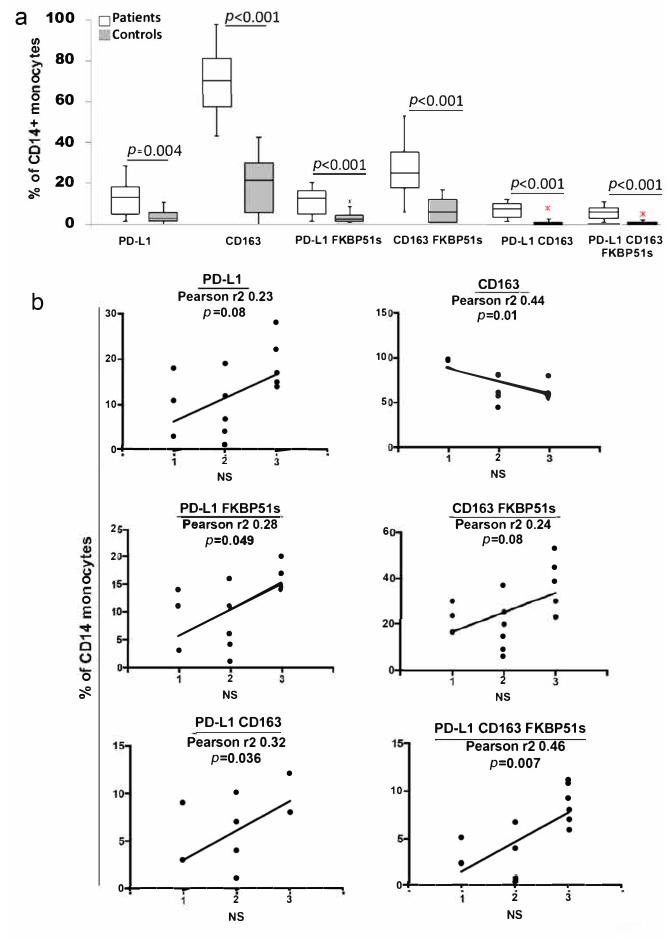
Figure 2. PD-L1+ peripheral monocytes in GBM patients ( a ) Box plots of counts of the whole PD-L1+ and CD163+ monocytes and their subsets co-expressing FKBP51s+ or a combination of PD-L1 and CD163 in the study population (14 patients and 14 healthy donors). Counts were performed on CD14-gated PBMCs. The graph was generated using Microsoft Excel.app 16.43. ( b ) Linear regression with Pearson correlation of M2 monocyte subsets and necrosis score. Graphs were generated using Prism GraphPad 7.0a Macintosh. NS = necrosis